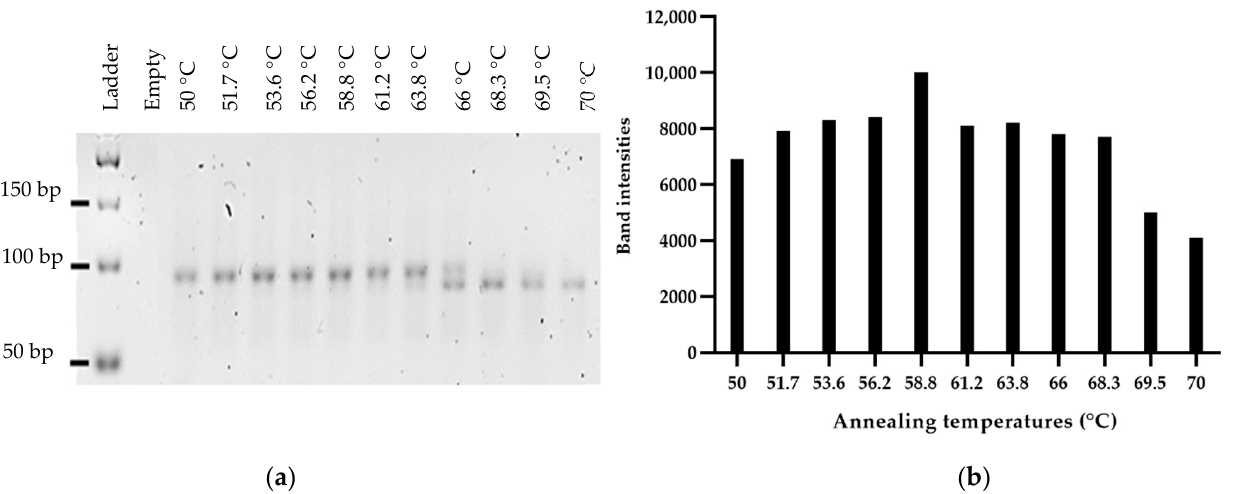
Figure 1. ( a ): Agarose gel electrophoresis (4% agarose, 90 V, 2 h in TAE 1 × GelRed ® ) of the PCR products of the aptamer library with 20 cycles of amplification and annealing temperatures ranging from 50 °C to 70 °C. The legends above the gel correspond to the tested annealing temperatures. ( b ): Representation of the band intensities (ImageJ) as a function of the tested annealing temperature. Band intensities represent the amount of dsDNA produced.